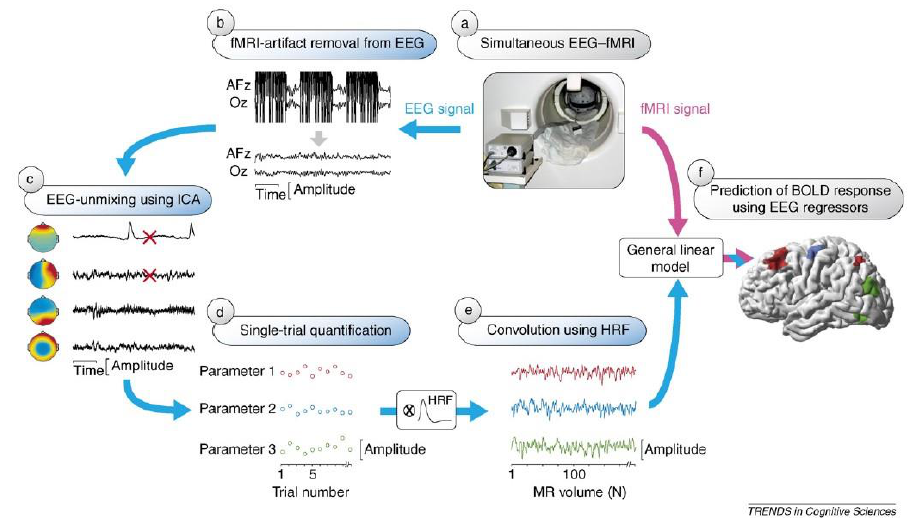
Figure 5. ( A ) Grand average of ERPs at PO7 and PO8 with the P1 and N1 peaks marked. ( B ) Stacked plots of single-trial responses at PO7 and PO8 for a representative subject, illustrating a consistent positivity for the P1 component and a consistent negativity for the N1 component. ( C ) Topography of the P1 (top) and N1 (bottom) components. ( D ) BOLD activation (z scores) in response to target stimuli in the Passive, Count, and Respond conditions (second-level mixed-effects FLAME, n = 13, Cluster-corrected threshold Z = 2.0, p = 0.05). Reproduced with permission from Ref [97]. Copyright 2014 MIT Press.